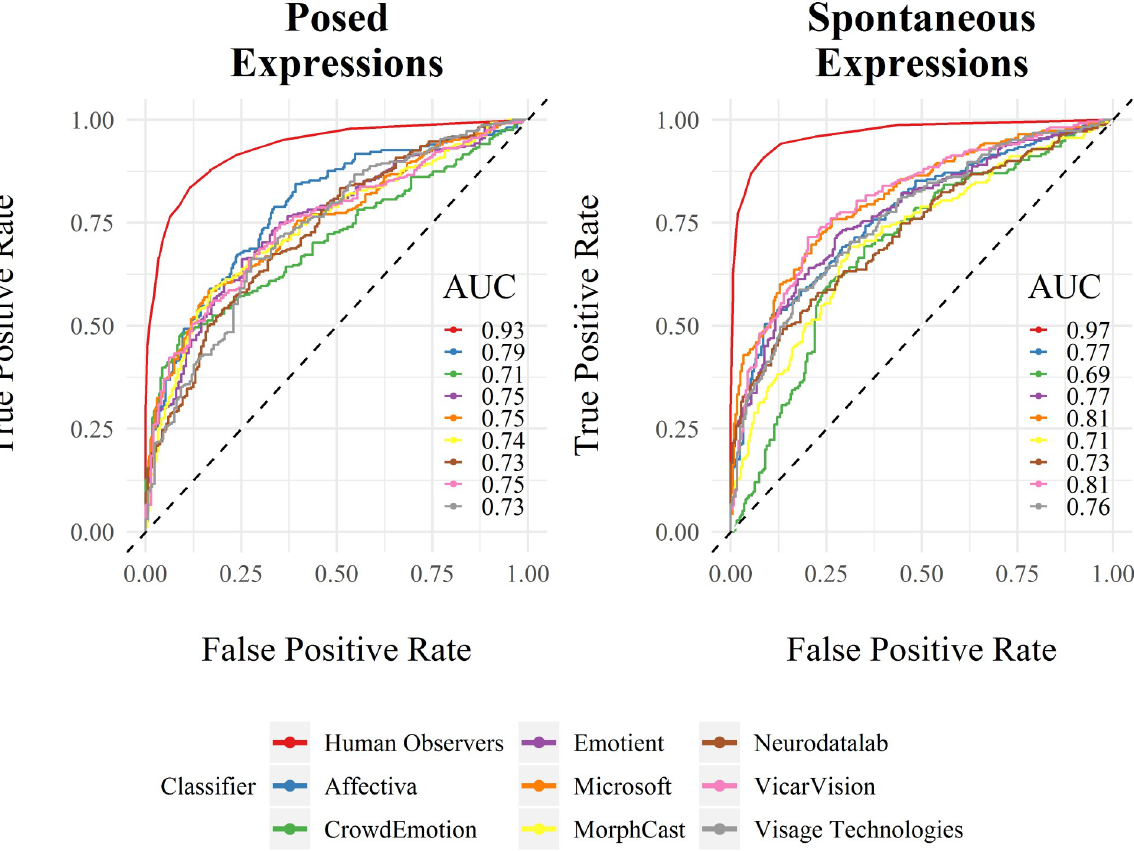
Fig 2. Receiver Operating Characteristic (ROC) curves and corresponding Area Under the Curve (AUC) depicting the True Positive Rate (TPR) against the False Positive Rate (FPR) for human observers and automatic classifiers separately for posed and spontaneous expressions. The dotted diagonal line in the ROC space indicates chance